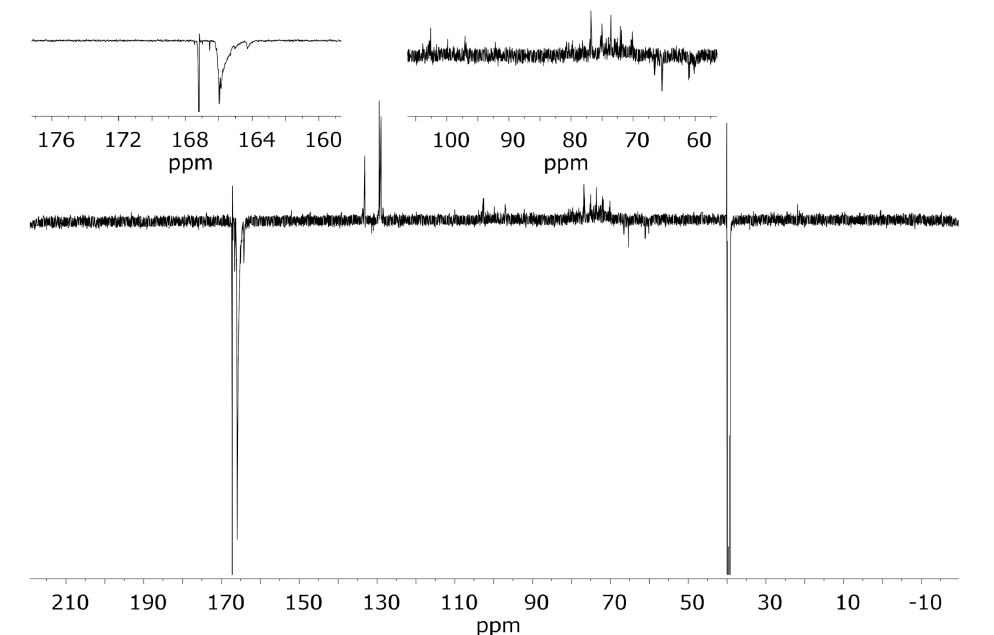
Figure 3. DEPTQ carbon NMR spectrum of benzoylated wood in DMSO -d 6 /LiCl, 24k